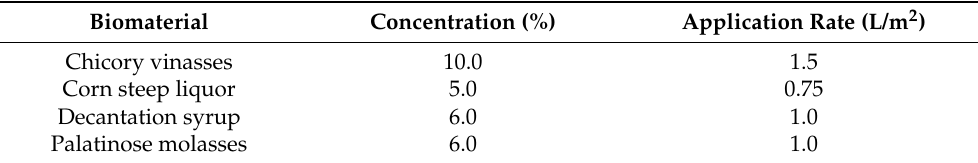
Figure 1. Prepared biomaterial solutions: ( a ) chicory vinasses, ( b ) corn steep liquor, ( c ) decantation syrup, and ( d ) palatinose molasses. Table 1. Applied additive concentration and application rate of each